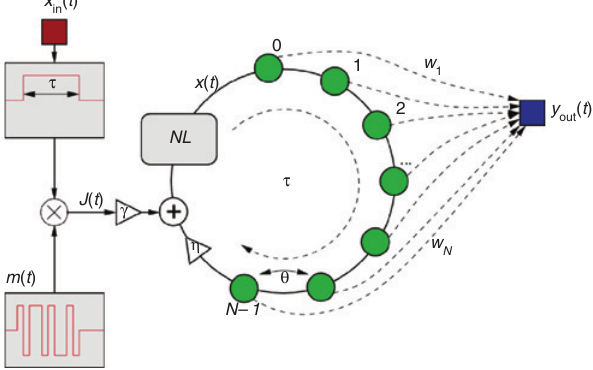
Figure 6: Structure of a delay line based reservoir computer. A one-dimensional input signal (in red) is first preprocessed using the masking function m ( t ). Virtual nodes are defined along the delay line and form the reservoir (in green). The output layer (in blue) is unaltered from the standard RC